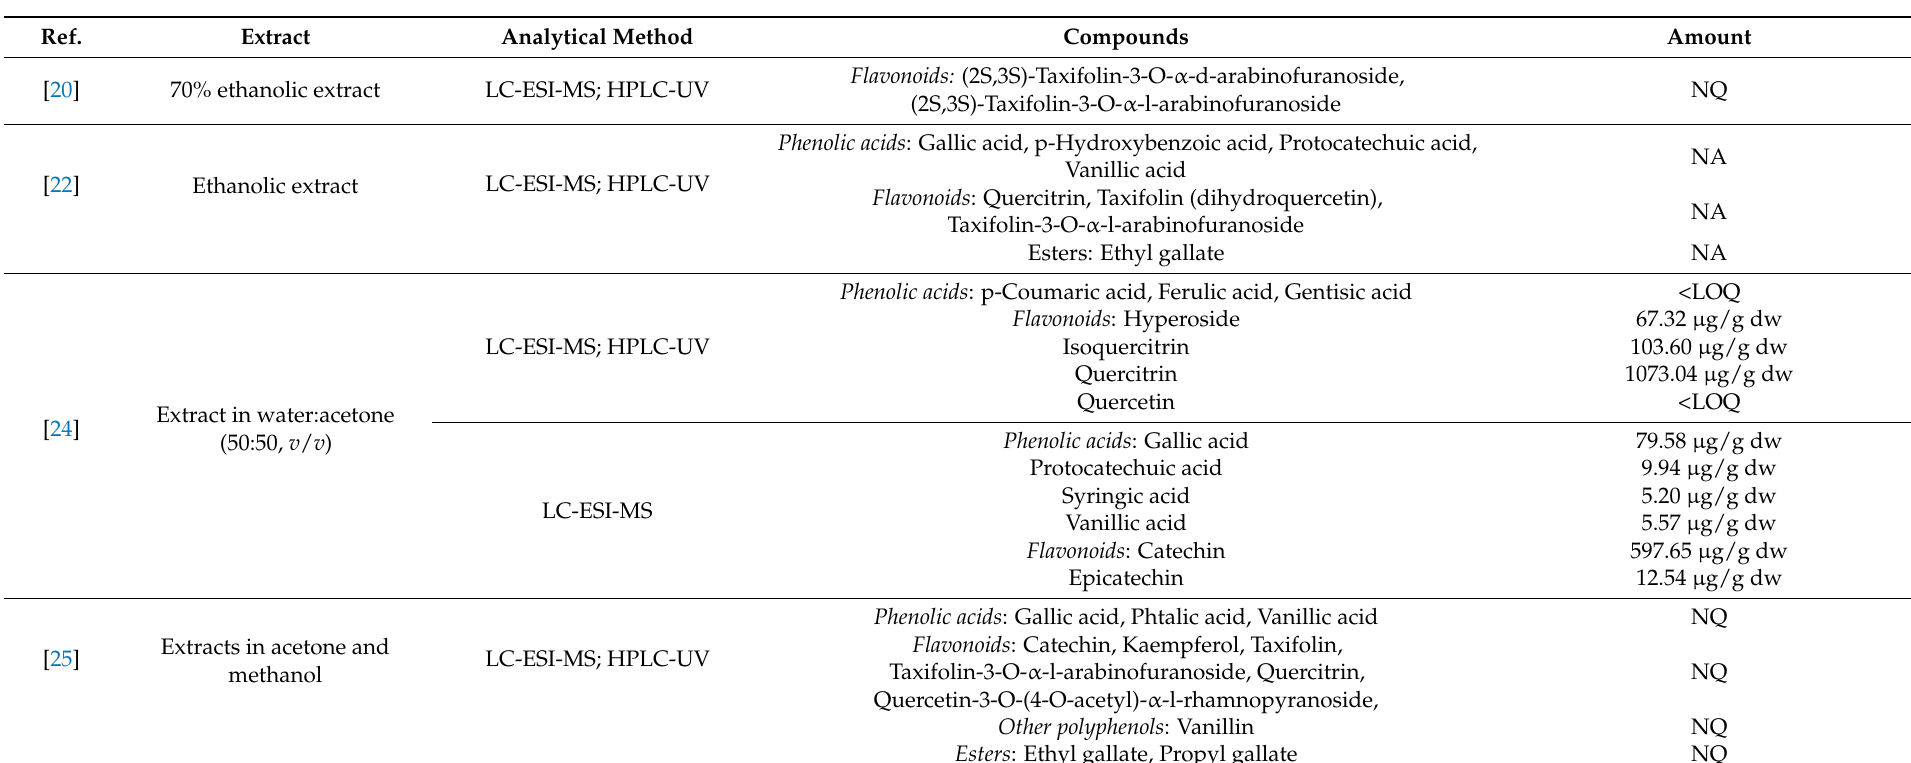
Table 2. Phenolic compounds identified and quantified in walnut